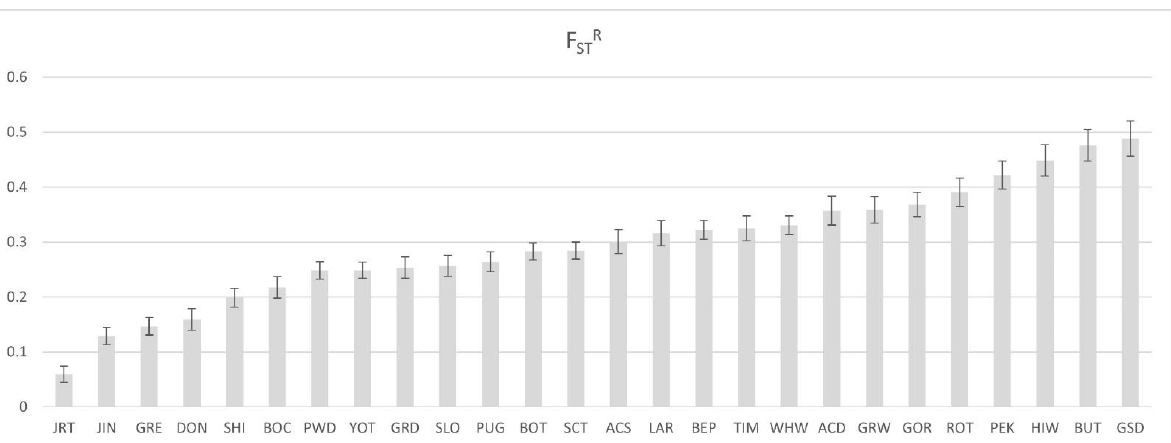
Figure 7. Pairwise F STR calculated from the RSPO2 3' UTR-associated region of the long- and short-haired Sapsarees and other dog breeds. The pairwise F STR between the breeds was calculated based on the definition of Reich et al. (2009). The error bar at the top of each bar graph indicates the 95% confidence interval.